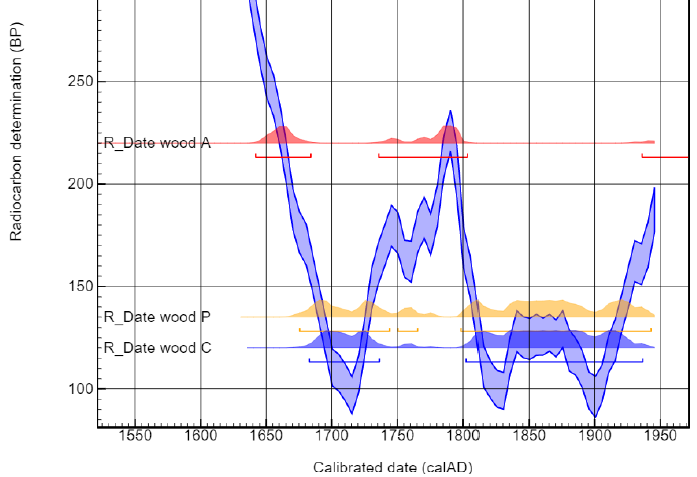
Figure 7. Calibration of the wood samples taken from the painting stretchers. The blue curve is the atmospheric calibration curve (Intcal20) used to calibrate 14 C dates before 1950 [26]. Radiocarbon dating results obtained for the canvas of four paintings and for the paint of one painting are presented in Table 4 and Figure 8. Table 4. 14 C Fraction Modern (F 14 C) results for the fibers taken from the painting canvases and for a sample of paint taken from the white paint of the Abstract painting. F 14 C is the unit used for post- bomb samples. Radiocarbon dates were calibrated using the Bomb13 NH1 post-bomb atmospheric curve [27] (Figure 8). See text for details. Painting